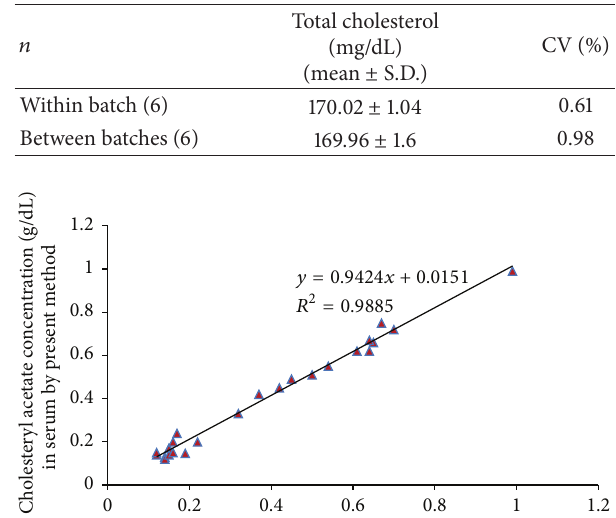
Table 2: Within batch and between batches coefficients of variation for determination of total cholesterol in serum samples.